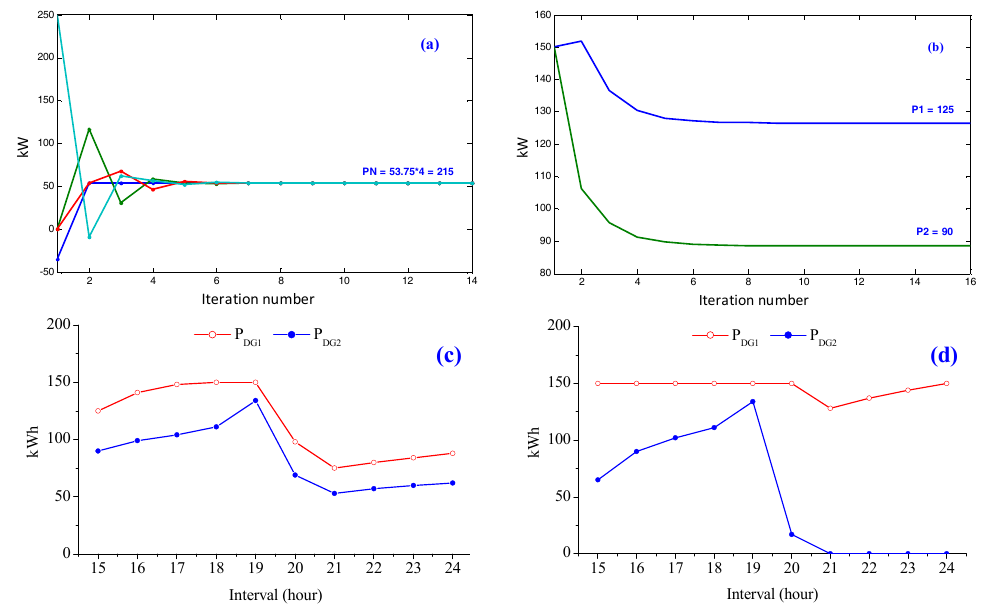
Figure 17. Operation results of isolated part at interval 15: ( a ) information sharing (shortage amount); ( b ) distributed optimization; ( c ) the output power of DG units for remaining intervals; and ( d ) the output power of DG units for remaining intervals (rescheduling by MG-EMS).